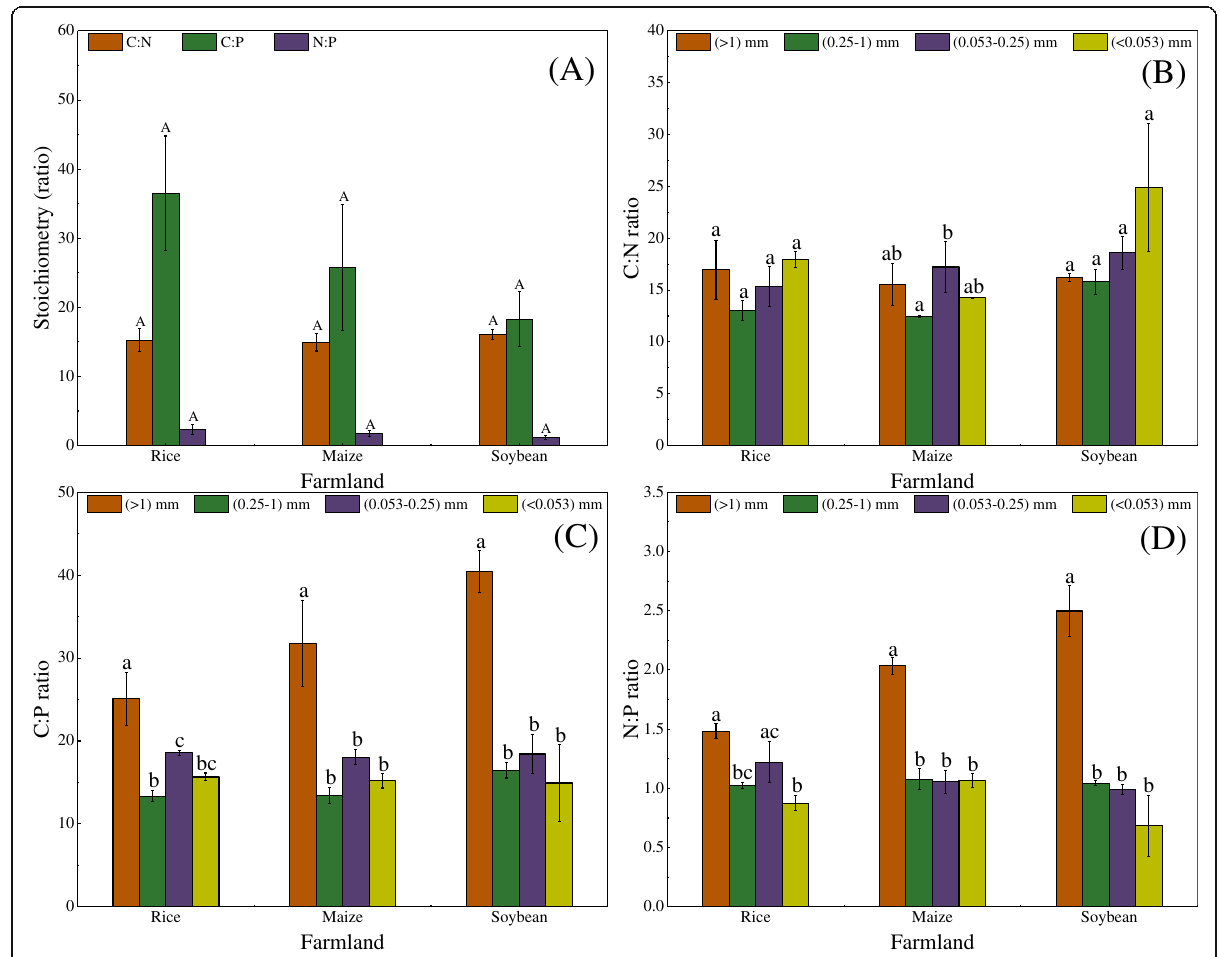
Fig. 1 Changes in nutrient stoichiometry related to soil aggregate structure under different croplands. The uppercase letters represent the difference in nutrient stoichiometry derived from different croplands, and the lowercase letters represent the difference in nutrient stoichiometry derived from soil aggregate